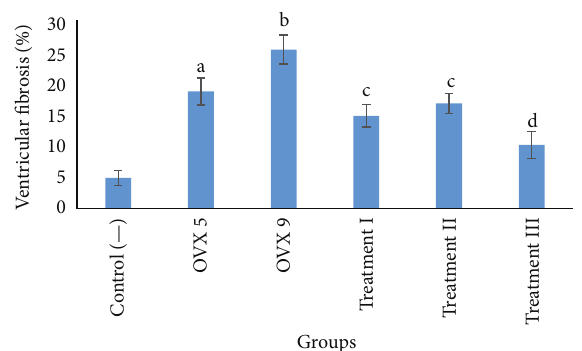
Figure 3: Mean of ventricular fibrosis in each group (%). a 𝑝 < 0.05 compared to control (—), OVX 9, treatment III groups; b 𝑝 < 0.05 compared to all other groups; c 𝑝 < 0.05 compared to control (—) and OVX 9; d 𝑝 < 0.05 compared to OVX and control (—). OVX 5: 5-week ovariectomy; OVX 9: 9-week ovariectomy. Treatments I, II, and III reflected 9-week ovariectomy treated with 500, 1500, and 2500 mg/kgBW ceplukan leaf’s methanolic extract,